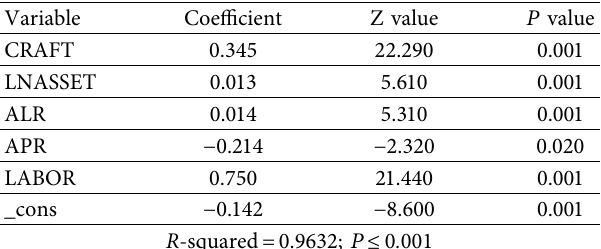
Table 5: Estimated results of the relationship between craftsman’s spirit and construction industry economic growth